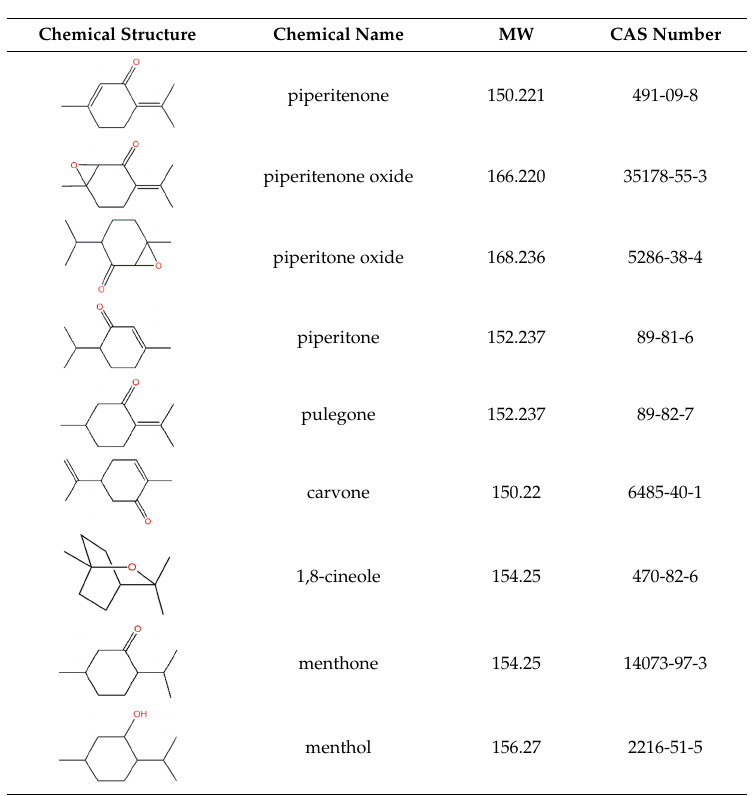
Table 2. Chemical structures, names, MWs and CAS numbers of some of the most common constituents in EO of Calamintha nepeta (L.) Savi